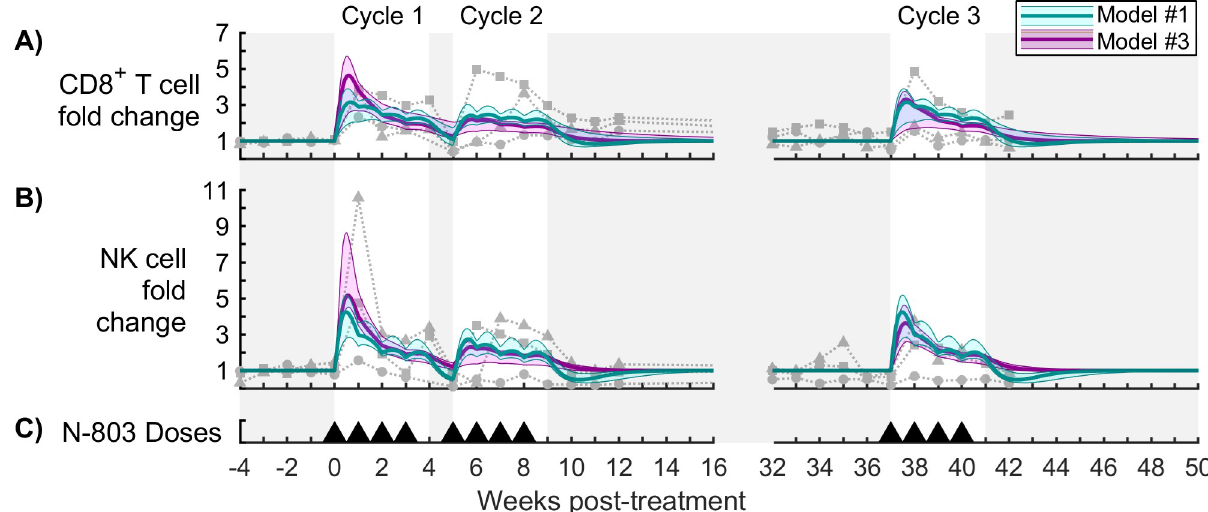
Fig 5. Model comparison for cytotoxic cells. Panels (A,B) show fold change in CD8 + T cells and NK cells in the peripheral blood, respectively, for the model without drug tolerance (cyan model #1) and the model without viral escape (magenta model #3). The bold line corresponds to the best-fit model, and the shaded region corresponds to the Bayesian 95% credible interval. See S1 Fig for corresponding parameter distributions. Data from N- 803-treated SIV-infected NHPs are shown as different symbols for each NHP [16]. Panel (C) shows timing of 0.1 mg/kg subcutaneous doses of N-803. See S2 Fig for models #2 and